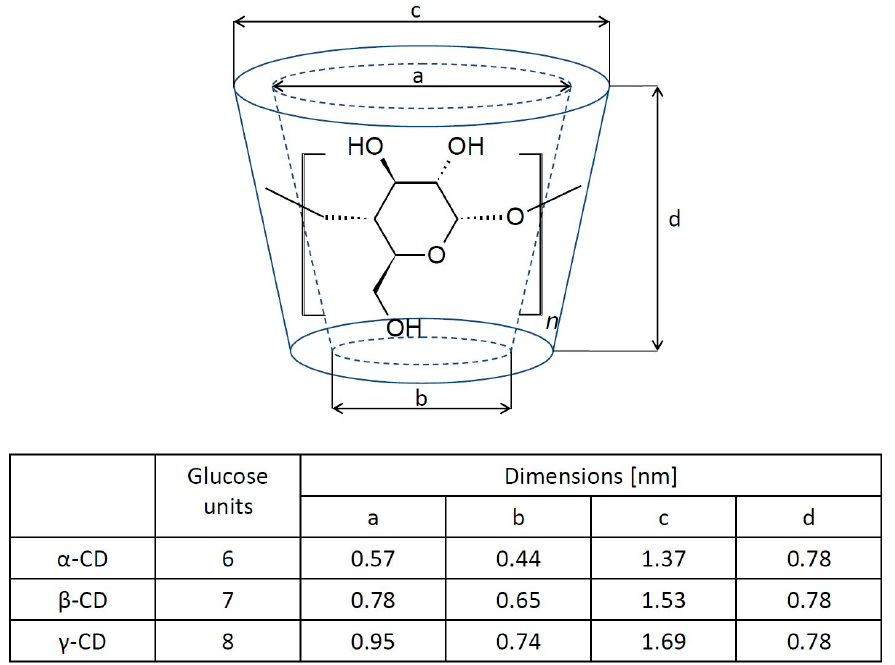
Figure 1. The molecular structure of cyclodextrin molecules and their corresponding geometric dimensions [20].